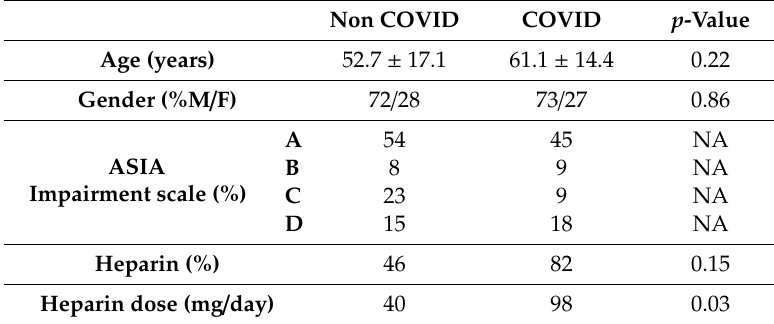
Table 1. Clinical characteristics of the subjects used in the study. ASIA, American Spinal Injury Association; M/F, male/female; NA, not applicable.